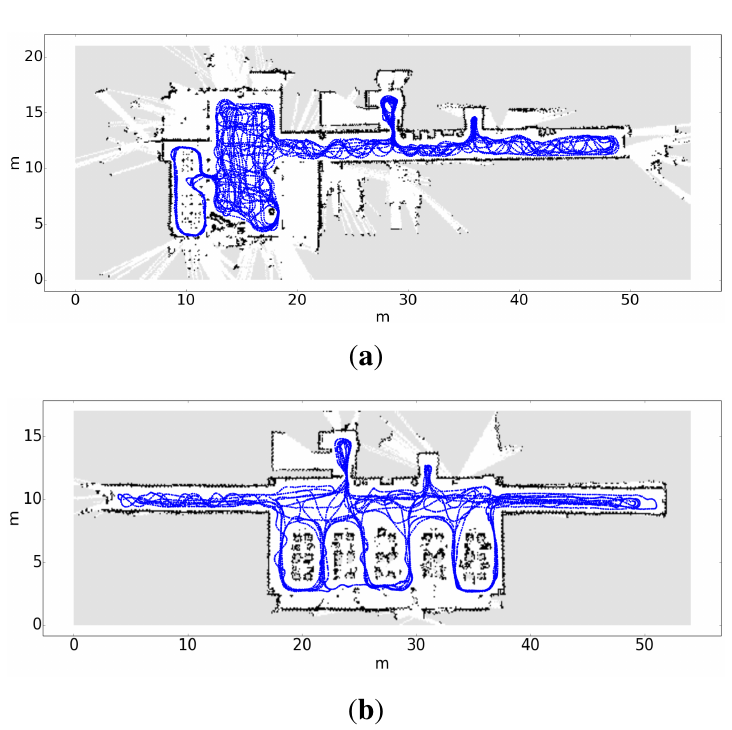
Figure 7. Trajectory followed by the robot during the capture of the experimental data. ( a ) Trajectory followed in the first floor; ( b ) Trajectory followed in the second